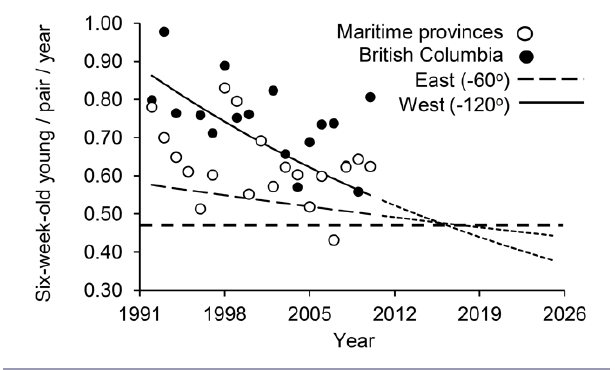
Fig. 4 . Reproductive success of Common Loons ( Gavia immer ) across southern Canada as a function of longitude and year between 1992 and 2010, with projections into the future. Shown are model-averaged predictions from the best model from the first part of the analysis (Table 1), with longitude held at two selected values and lake area held at its median value. Means are shown across each of several arbitrary bin classes (dots) for two different sets of provinces to illustrate model fit, but be aware that these means were not the data used to fit the model. The horizontal dashed line is the minimum estimated number of six-week-old young per pair per year (0.48) required to offset adult and juvenile mortality (Evers